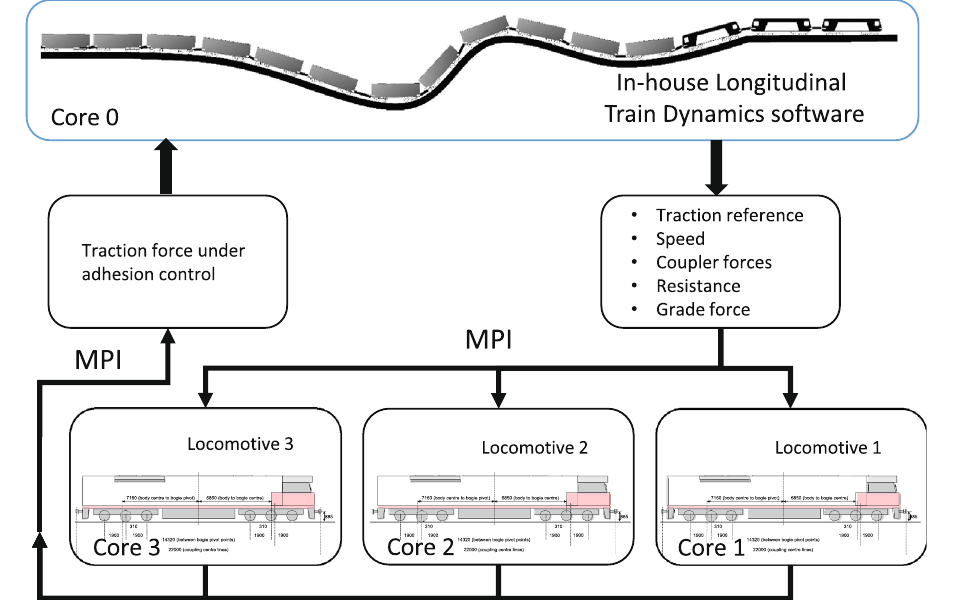
Fig. 4 Simulation strategy for 2D locomotive and LTD